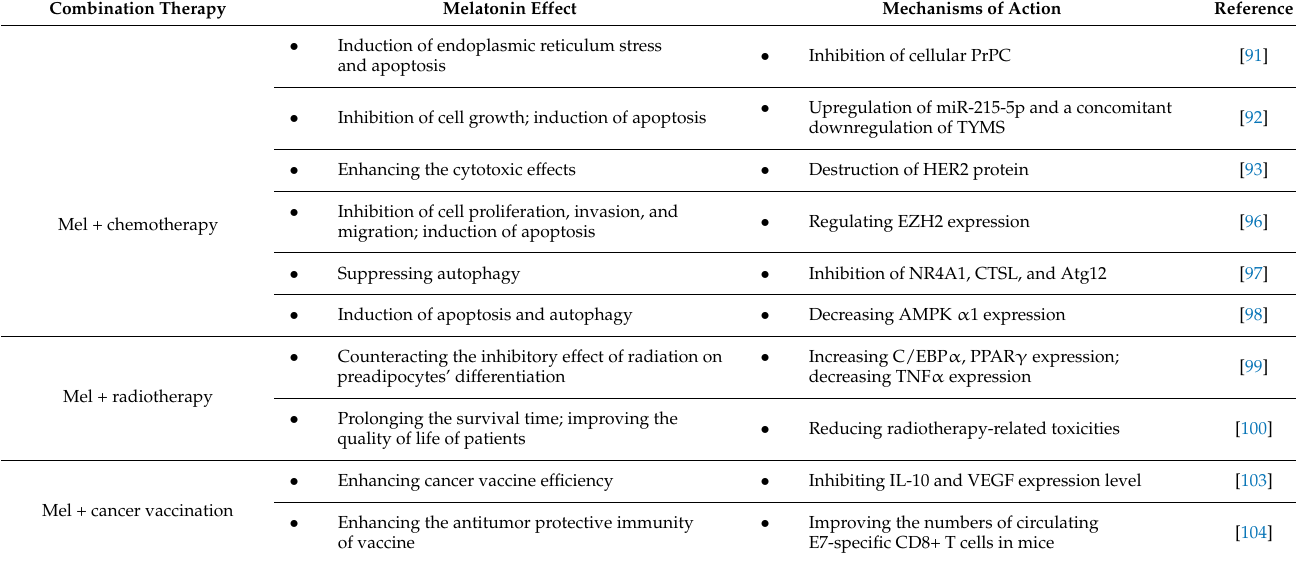
Table 2. Melatonin in combination with other anticancer